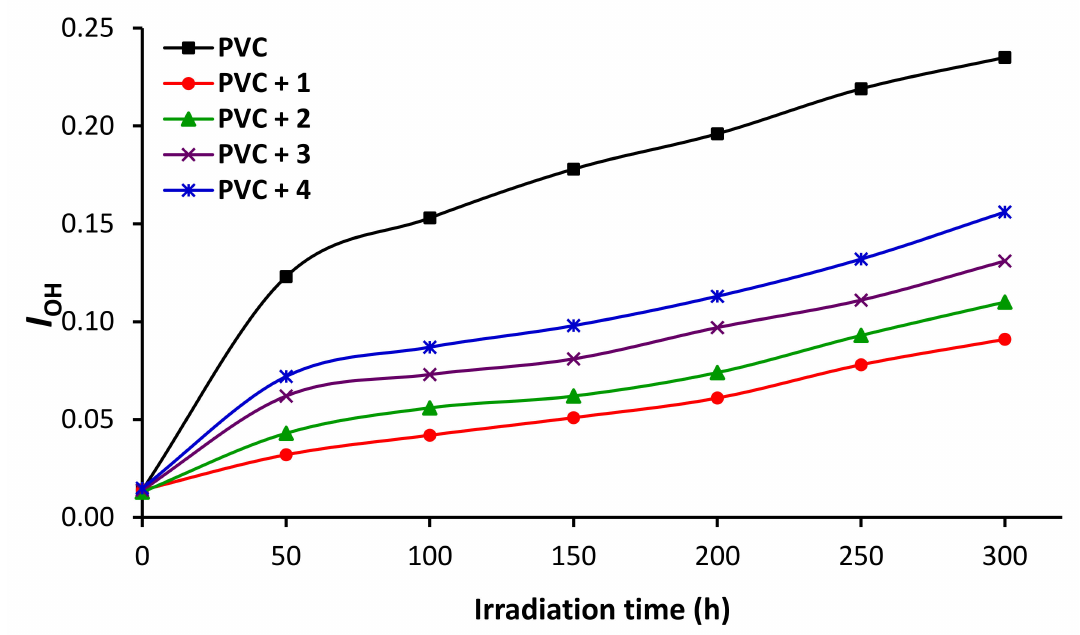
Figure 5. The I OH index as a function of time during the irradiation of pure and tin-complex blended